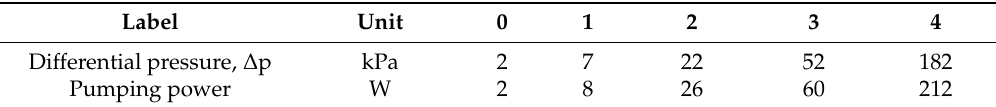
Table 2. Conditions for the third pipe at different downward displacements under the design conditions, according to Figure 6.